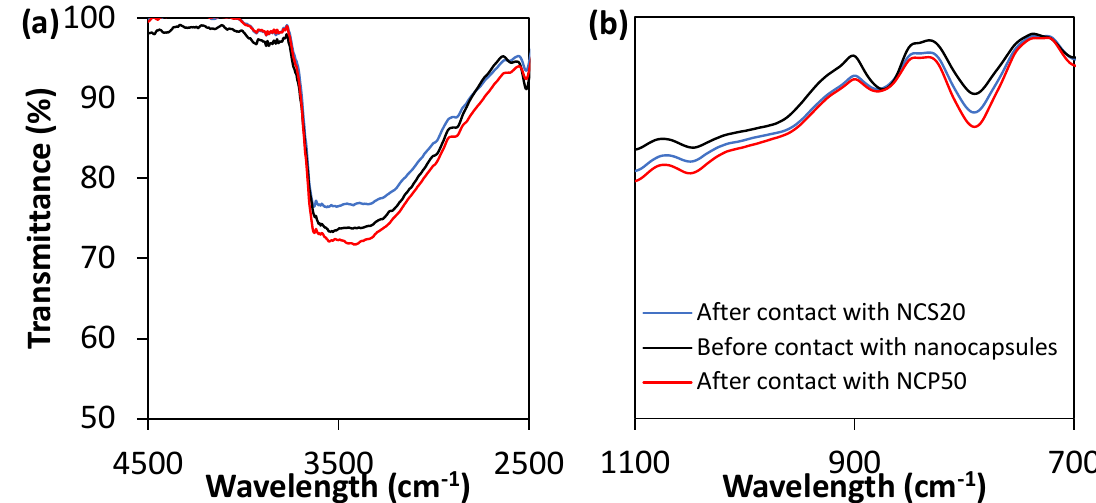
Figure 6. FTIR spectra of sandstone before, and after contact with dispersions of 10,000 mg/L of NCS20, and NCP50 in deionized water, focused on ( a ) O–H region 3500–3000 cm −1 , and ( b ) fingerprint region for bands centered at 1090, 890, 800, and 690 cm −1 .